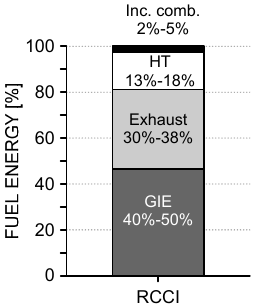
Figure 2. Typical apportionment of the fuel energy among the different outgoing energy paths during RCCI combustion.